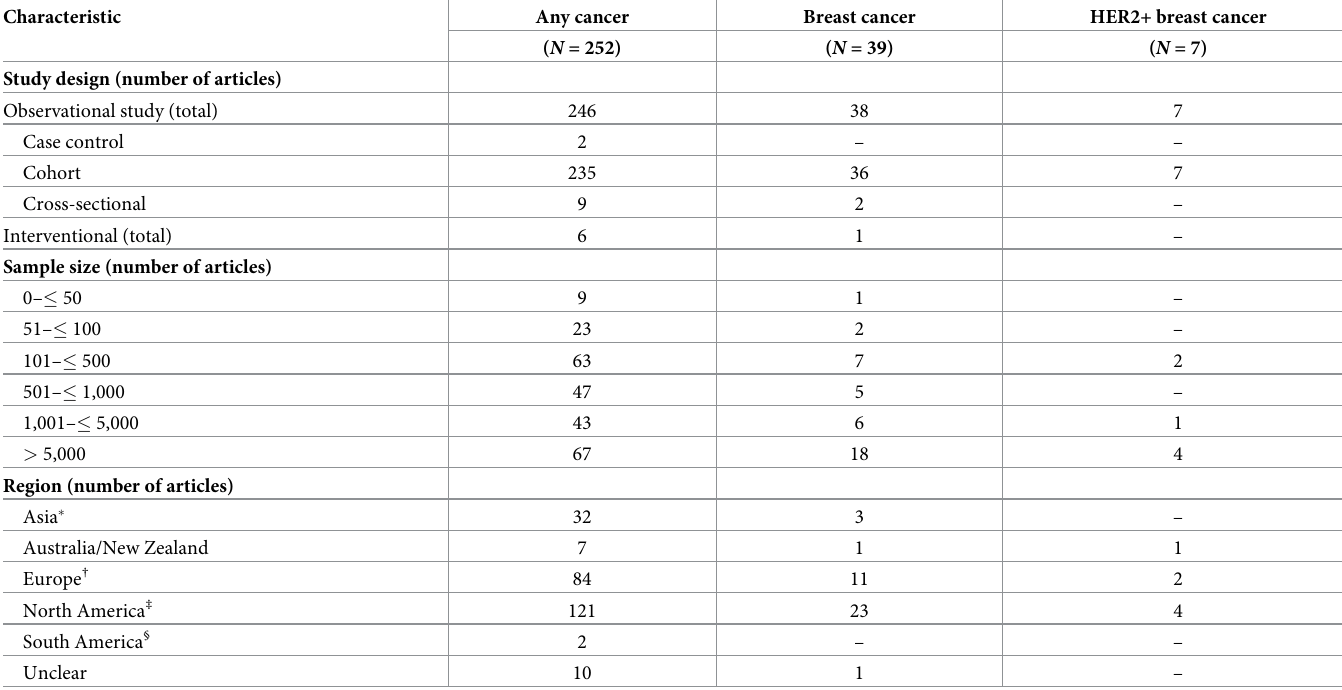
Table 3. Study characteristics of articles included in this